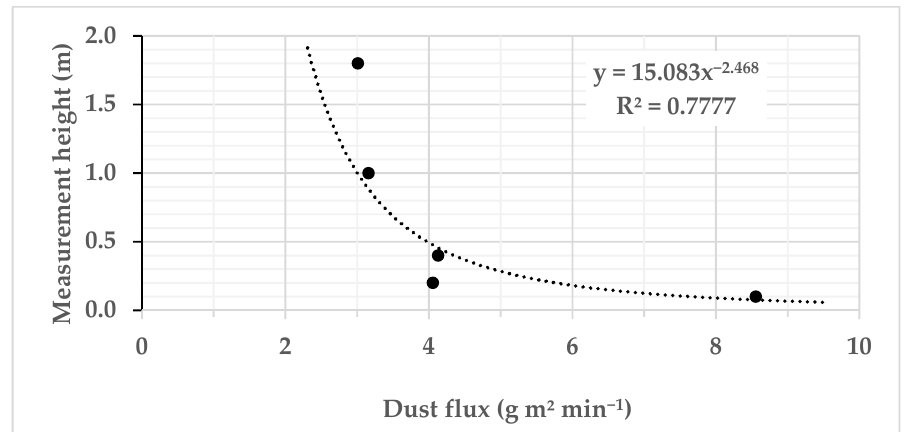
Figure 9. Vertical distribution of collected material from masts (mean) .